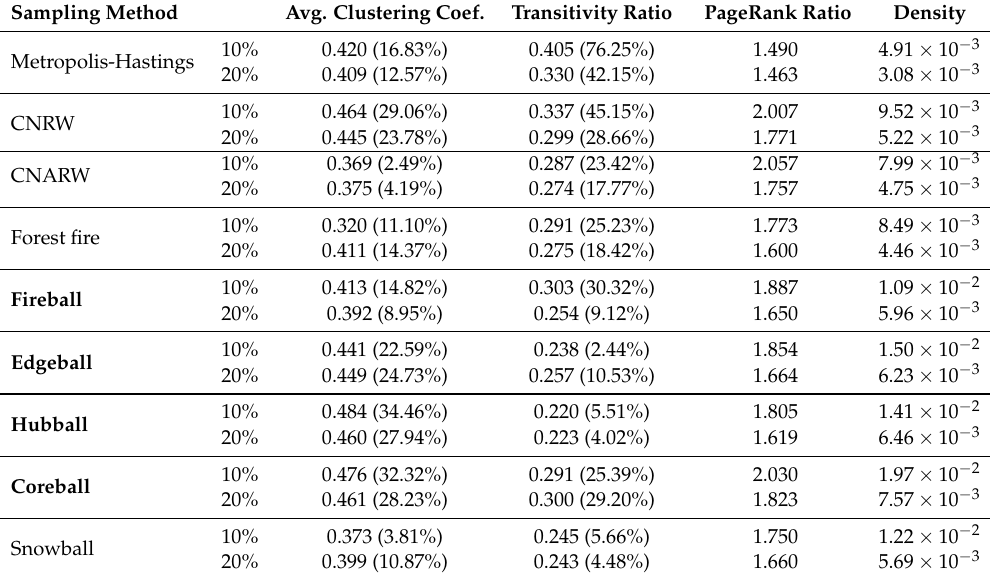
Table 3. Numerical results for the Facebook graph sampled at 10% and 20%. Full graph’s average clustering coefficient is 0.36, transitivity ratio is 0.23, density is 6.7 × 10 − 4 . Relative error for the average clustering coefficient and transitivity ratio is shown between